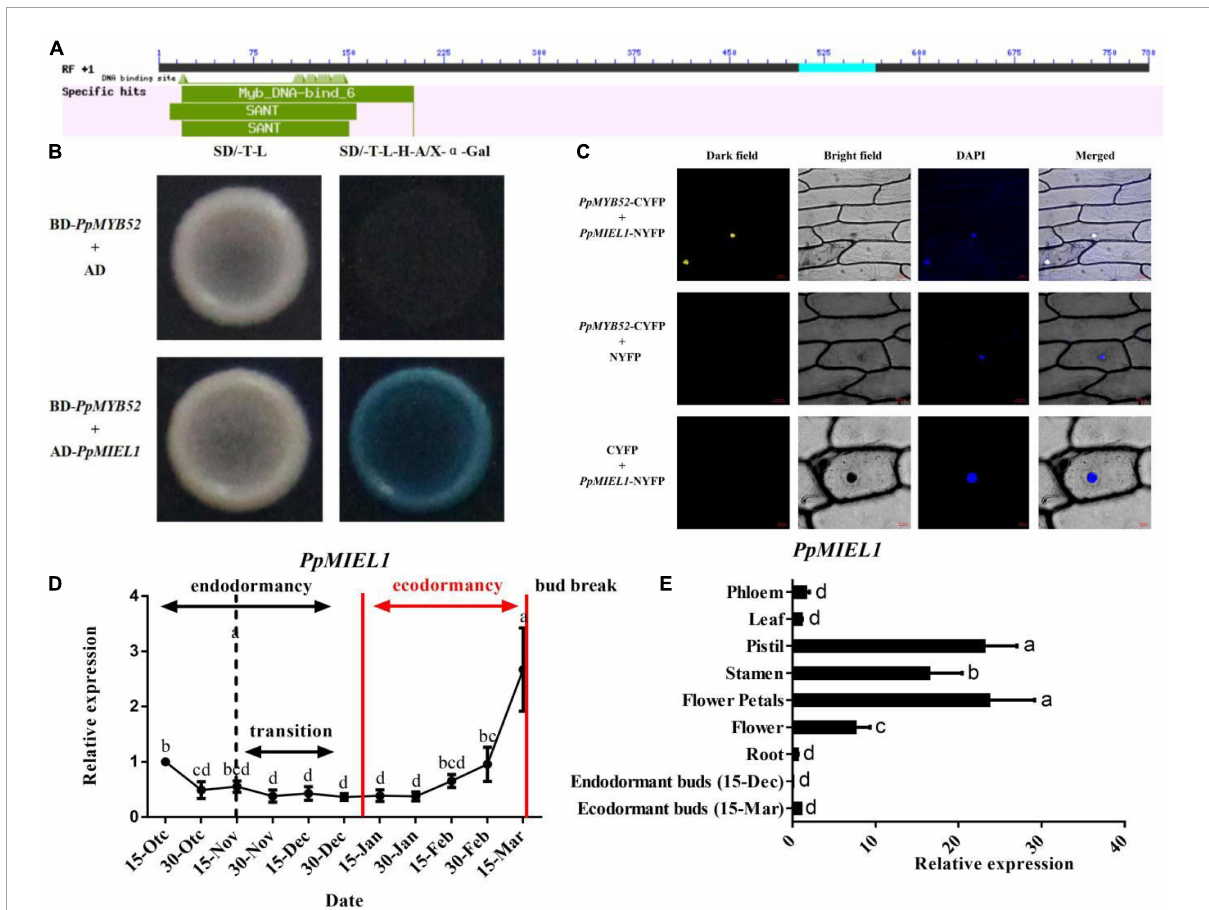
FIGURE1 PpMYB52 interaction with PpMIEL1 and the expression pattern of PpMIEL1 . (A) Analysis results of conserved domains according to the NCBI. (B) PpMYB52 interacts with PpMIEL1 in yeast. Because of the autoactivation of the full-length PpMYB52 protein, we used a 1–300 bp region to perform the experiment. Yeast cells transformed with BD- PpMYB52 (1–300 bp) + AD were included as negative controls. (C) PpMYB52 and PpMIEL1 BiFC verification. (D) Expression level of PpMIEL1 during the various stages of dormancy and bud break from 15 October 2021 to 15 March 2022. (E) Expression of PpMIEL1 in different tissues of Zhongyou 4